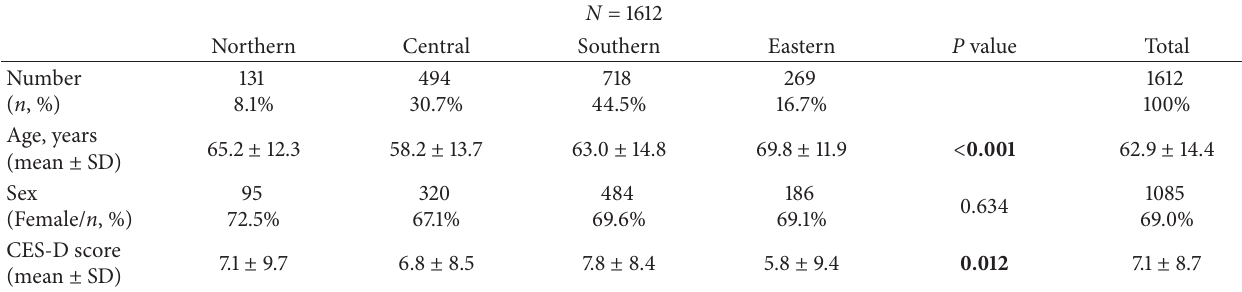
Table 1: Demographic characteristics of all recruited participants.